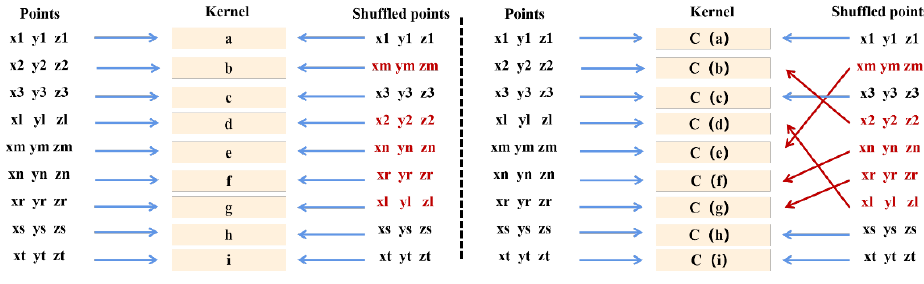
Figure 4. The convolution operation for the shuffled points with and without correspondences: (x1, y1, z1) are the point coordinates, a is the kernel point without correspondence, and C(a) is the kernel point with correspondence. The left-hand panel shows that the convolution without correspondences after shuffling will cause a different result. The right-hand panel shows that for the convolution operation with correspondences after the points have been shuffled, the shuffled points always indicate the same parameter, and the result is unchanged.